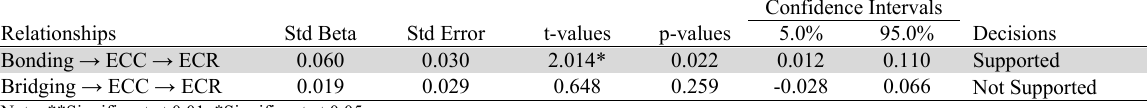
Result of Mediation Effect (Hypotheses